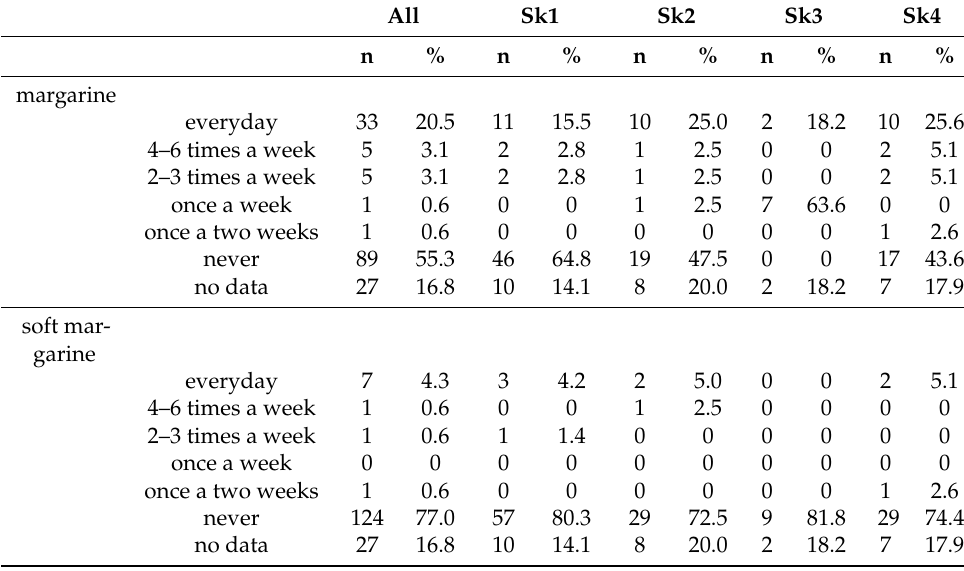
Table A3. Consumption of fats among investigated